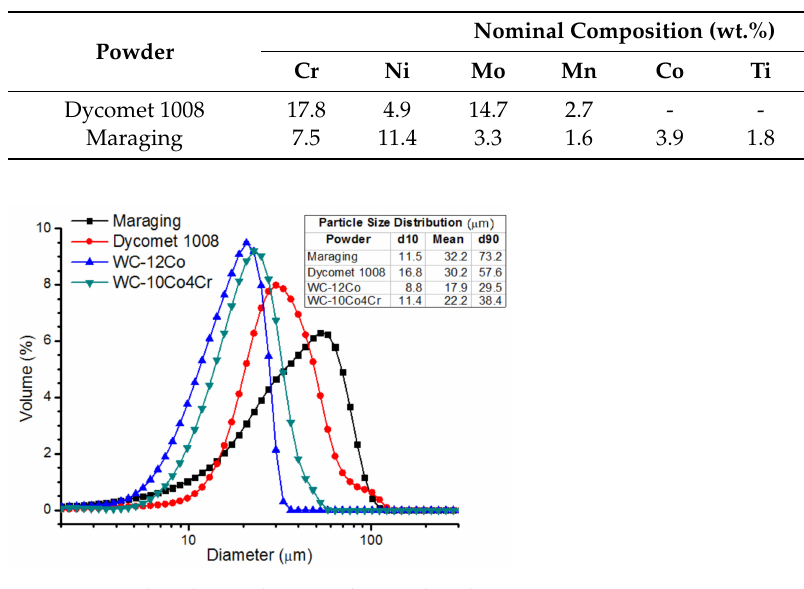
Figure 3. Feedstock powder particle size